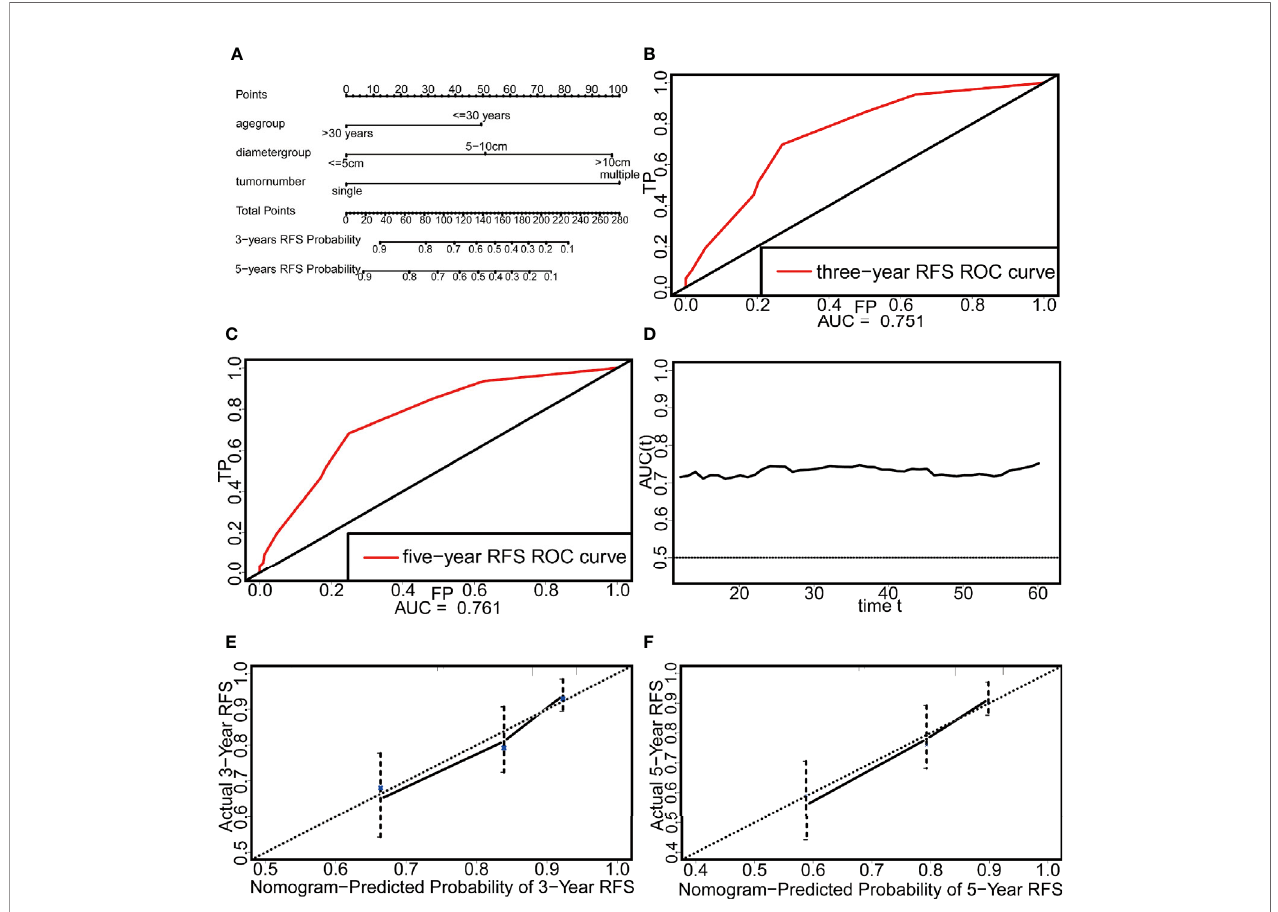
FIGURE 3 | The nomogram and the evaluation of its discrimination and calibration. (A) The nomogram based on Cox multivariate regression. (B) The ROC curve of three-year RFS. (C) The ROC curve of fi ve-year RFS. (D) The time-dependent ROC curve. (E) The calibration plot of three-year RFS. (F) The calibration plot of fi ve- year RFS.